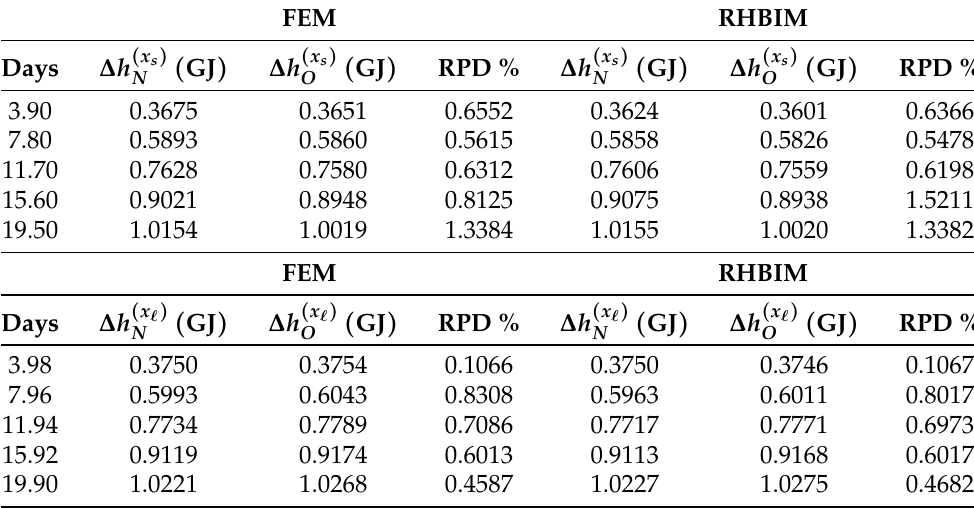
Table 6. RPD between both models and according to the numerical and semi-analytical solutions to the released thermal energy during a solidification process of the KNO 3 /NaNO 3